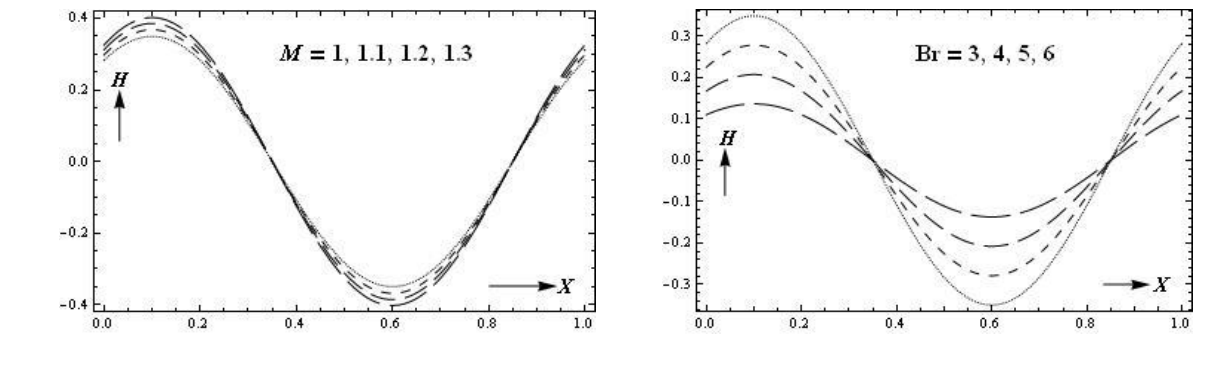
Figure 12 . Heat transfer coefficient for various values of magnetic number.